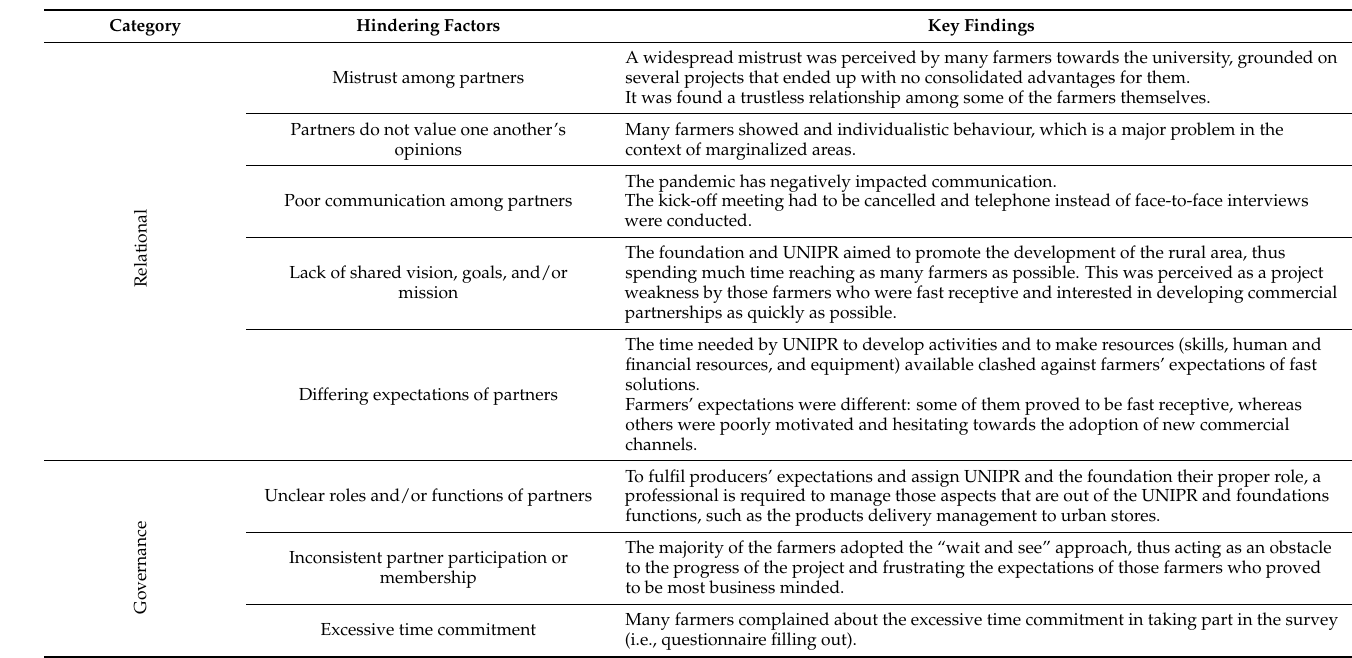
Table 4. Hindering factors of the “Parma, mountains of quality”